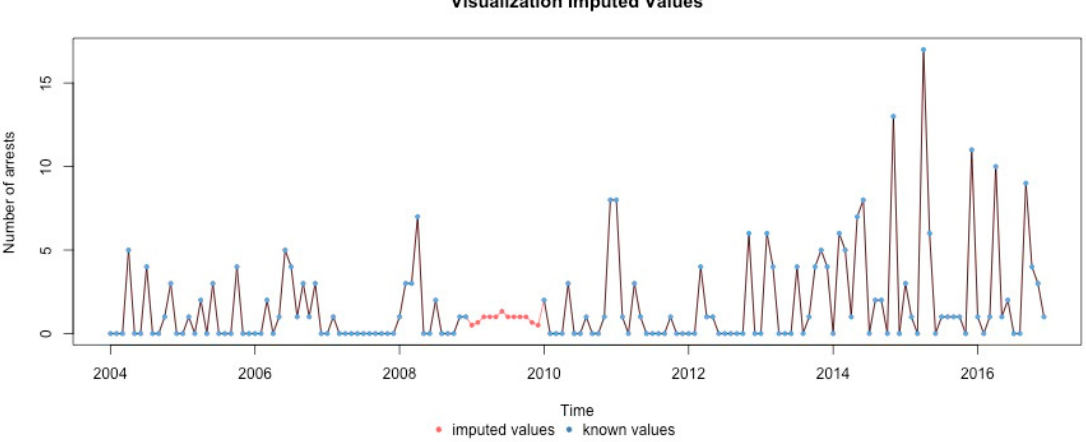
Figure A13. Methamphetamine-related organized foreign nationals crime arrests 2004–2016 in the Czech Republic – imputed missing values.